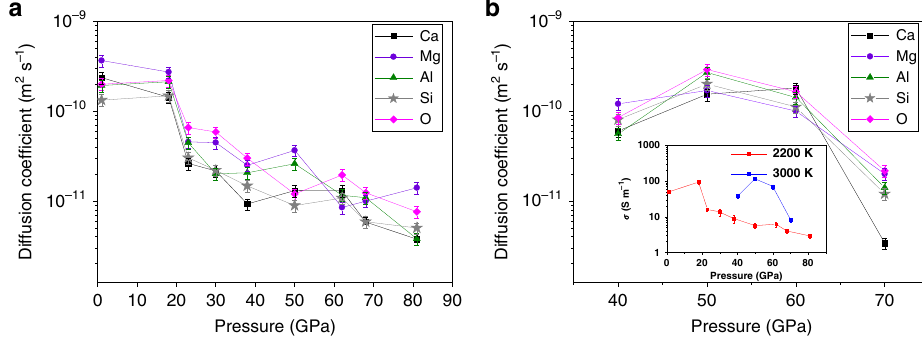
Fig. 3 Diffusion coef fi cient of the individual species vs pressure. Diffusion coef fi cients at a 2200 K and b 3000 K. (inset of b ) Electrical conductivity at 2200 and 3000 K. The error bars are the uncertainties in the diffusion coef fi cients. The errors of the mean were determined by considering (i) different intervals of the time origin of the molecular dynamics steps and (ii) minor variation in slope of the straight line used to fi t the mean squared